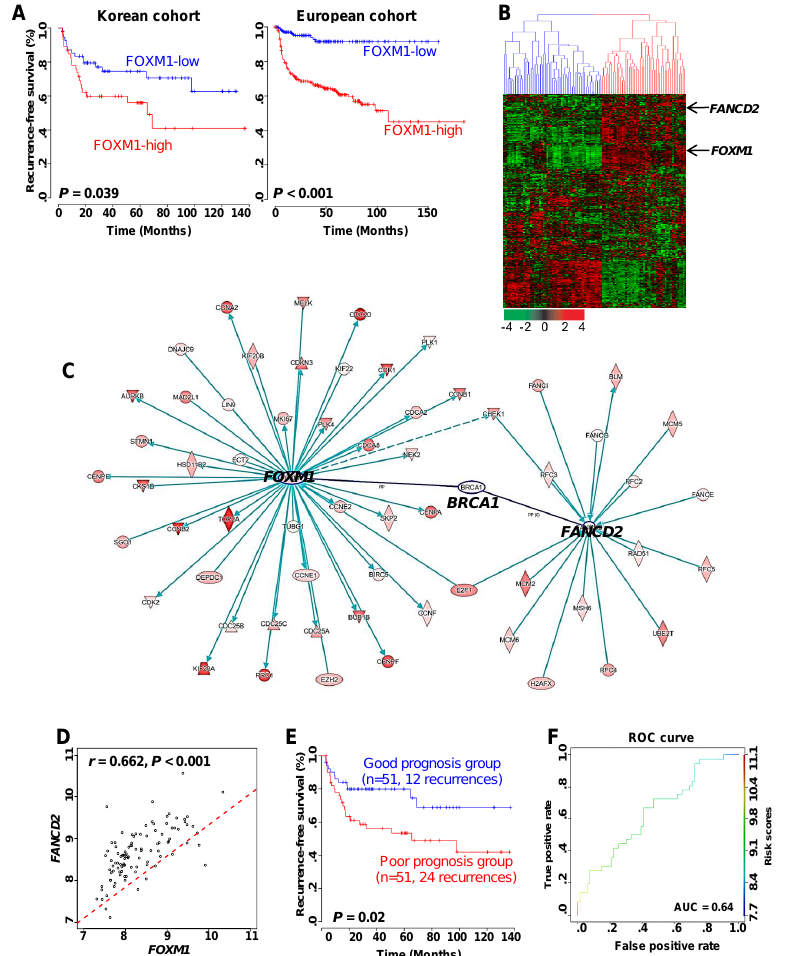
Figure 1. Recurrent prognosis and identification of genes associated with FOXM1 in NMIBC patients. ( A ) Recurrence-free survival (RFS) in the high and low FOXM1 expression groups in the Korean and Denmark cohorts. ( B ) Expression patterns of genes highly associated with FOXM1. A total of 509 genes that underwent cluster analysis had a high expression pattern with FOXM1 (r > 0.5) in the Korean cohort ( n = 102). ( C ) Gene to gene network analysis of FOXM1-correlated genes in NMIBC using IPA (Ingenuity pathway analysis). ( D ) Correlation analysis of FOXM1 and FANCD2 in NMIBC in NMIBC patient gene expression data. ( E ) Prognosis of the combination of FOXM1 and FANCD2. Risk scores of two patient subgroups were calculated by expression levels of FOXM1 and FANCD2 with GSE13507 (Korean cohort). Prognosis indicates the RFS of NMIBC. ( F ) ROC (receiver operating characteristic) curve for prediction of recurrence using the FOXM1 and FANCD2